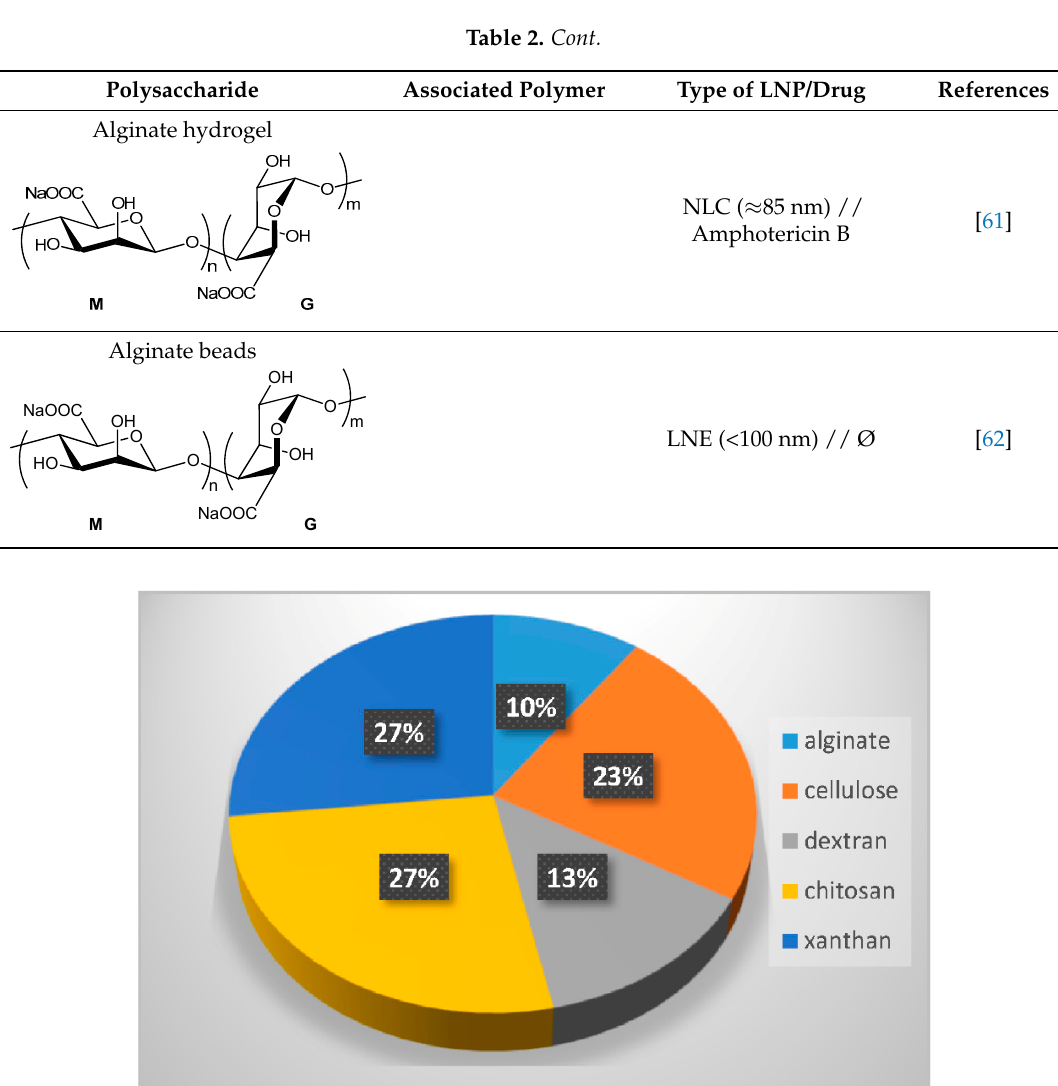
Figure 7. Percentage of the different polysaccharides used in the last 10 years in combination with LNP. Table 2. Combination of LNP and polysaccharide-based hydrogels in the past 5 years.